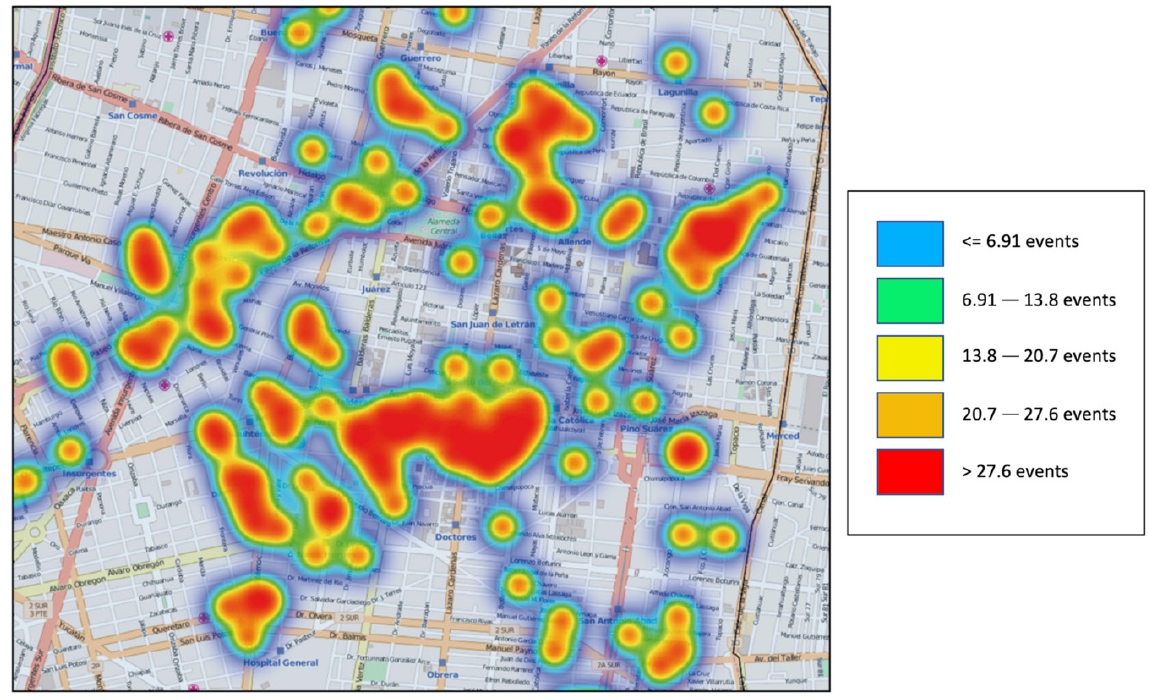
Figure 8. Traffic events represented by a heat map.